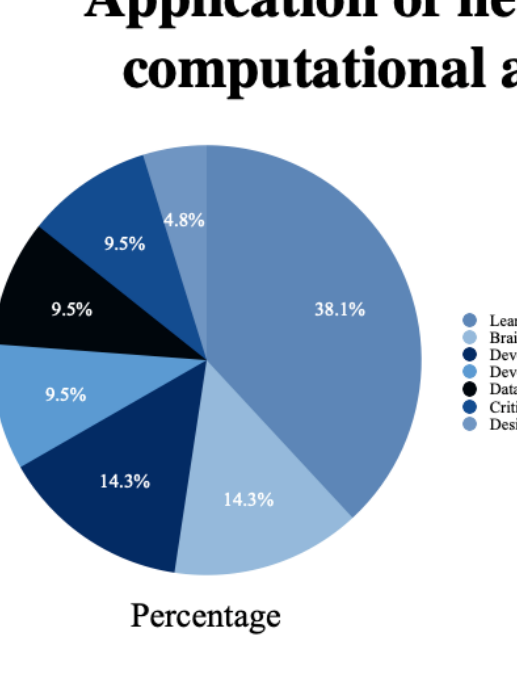
Figure 3. Main types of computational architectures developed through the application of neural networks to simulate brain